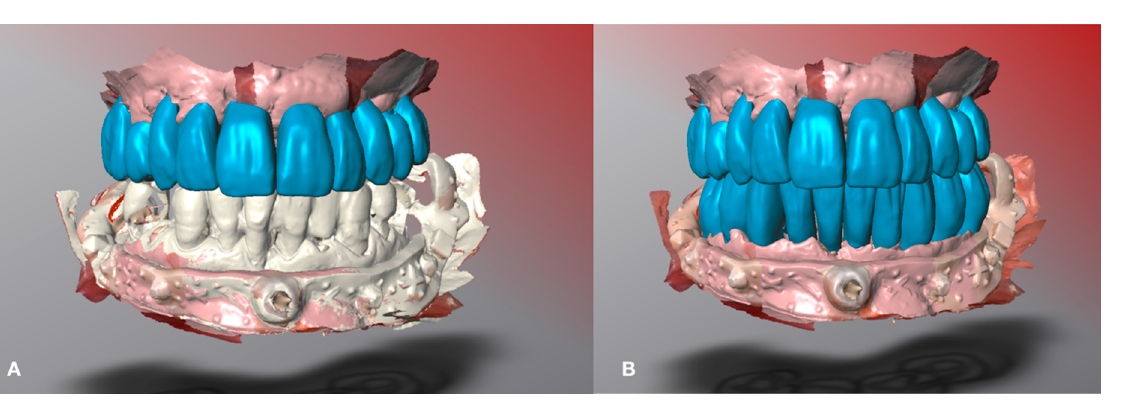
Figure 8. Postoperative impressions superimposed over preoperative records. ( A ) Postsurgical impressions have been superimposed on the preoperative records using the palatal rugae (for the upper jaw) and the resin digital index (for the lower jaw) in order to allow the transfer on the postsurgical impressions the data gathered prior to surgery, i.e., the vertical dimension and intermaxillary relationship. ( B ) Maxillary and mandibular preoperative impressions were then removed and the lab technician had the impressions with the position of the implants and the intermaxillary relationship.